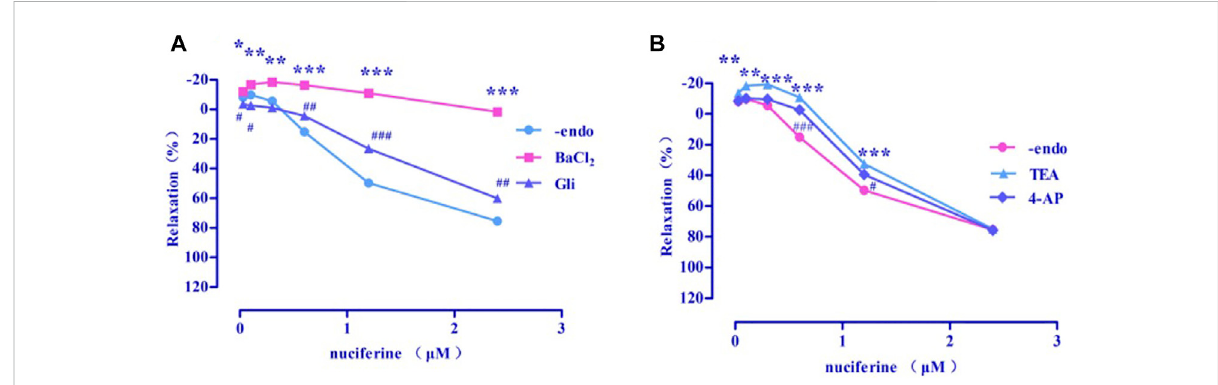
EffectsofK + channelblockersonnuciferineinducedvasorelaxation.Thedataareexpressedasthemeans±SDof6 – 8rats( n =6 – 8).(* p < 0.05, ** p < 0.01 and *** p < 0.001 vs. control group; # p < 0.05, ## p < 0.01 and ### p < 0.001 vs. control group).